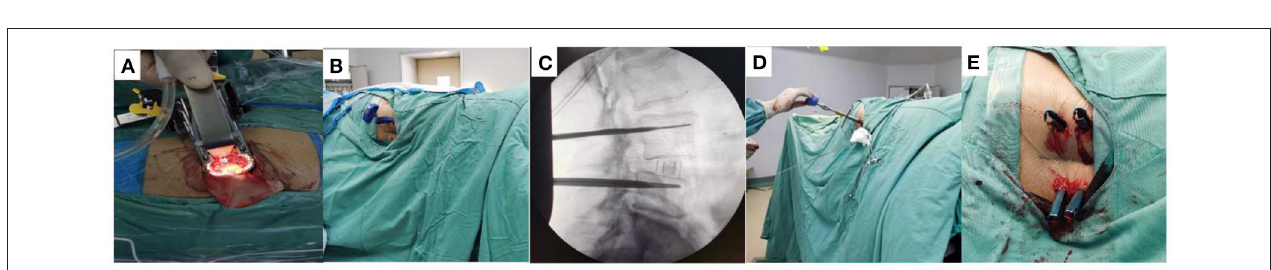
FIGURE 2 | Surgical procedure for single-position OLIF. (A) Establish OLIF channel and place cage. (B) Place puncture needle in the lateral position by “freehand”. (C) Verification of whether the guidewire positioning is satisfactory by fluoroscopy. (D) Pedicle screw placement. (E) Installation of the pedicle screw system.